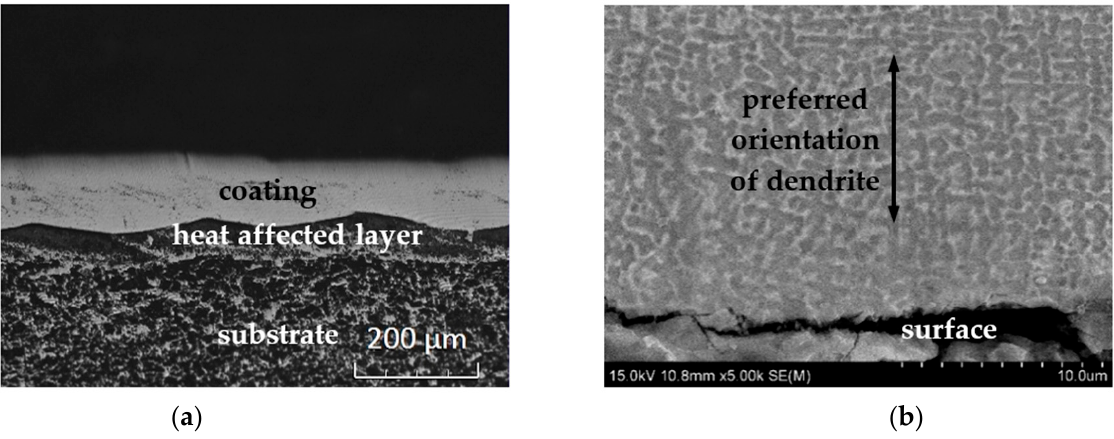
Figure 1. Cross-sectional views of the fabricated Fe 6 CoCrNiAl coating: ( a ) an optical microscope image; ( b ) a higher magnification image obtained via SEM.